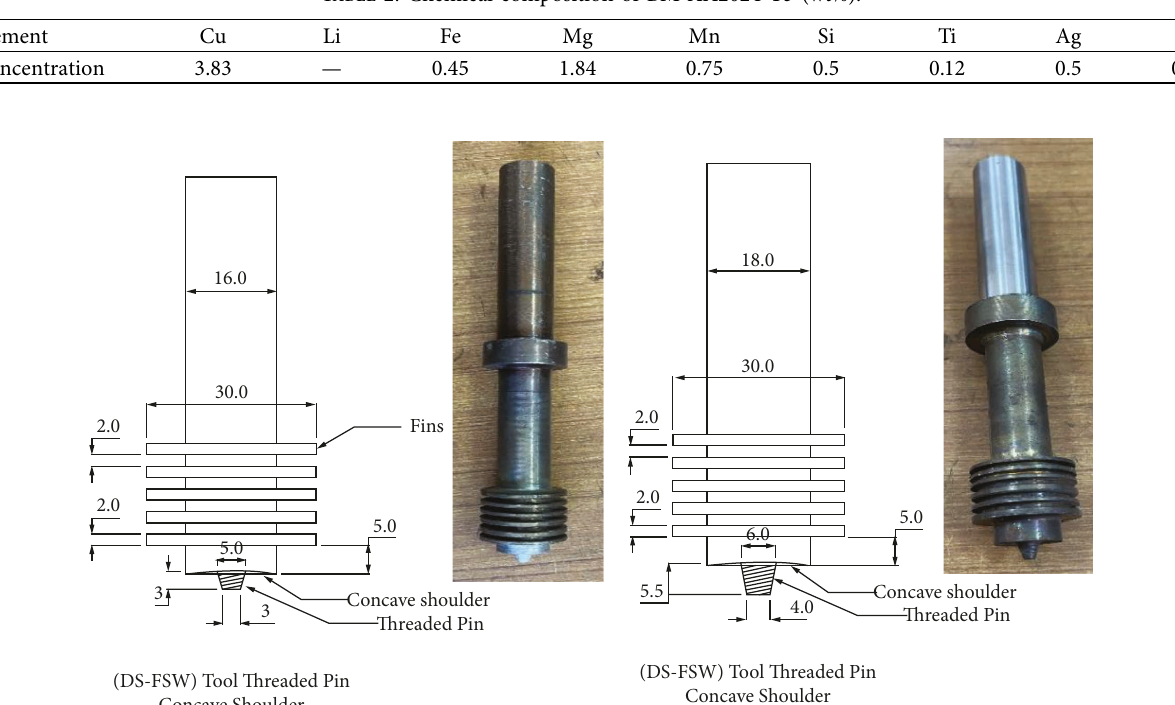
Table 2: Chemical composition of BM AA2024-T3